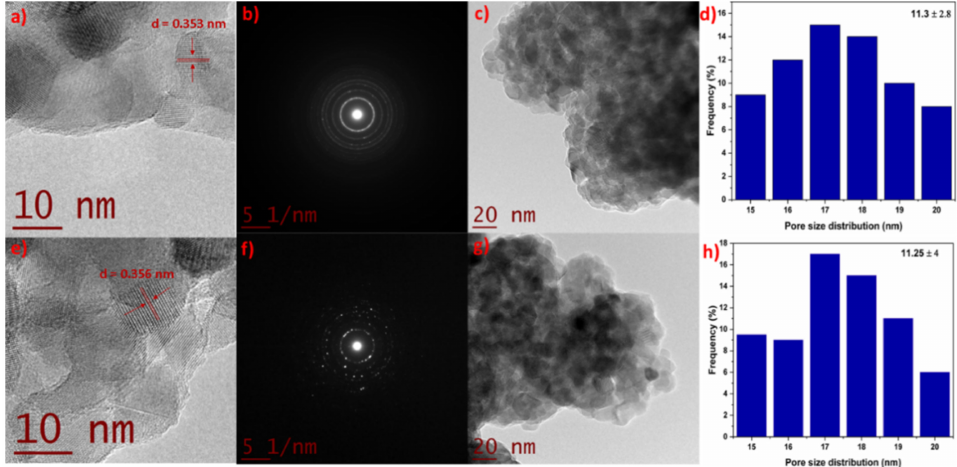
Figure 2. HR-TEM, SAED pattern, TEM and the size distribution of TZ-1 ( a – d ) and TZ-5 ( e – h )